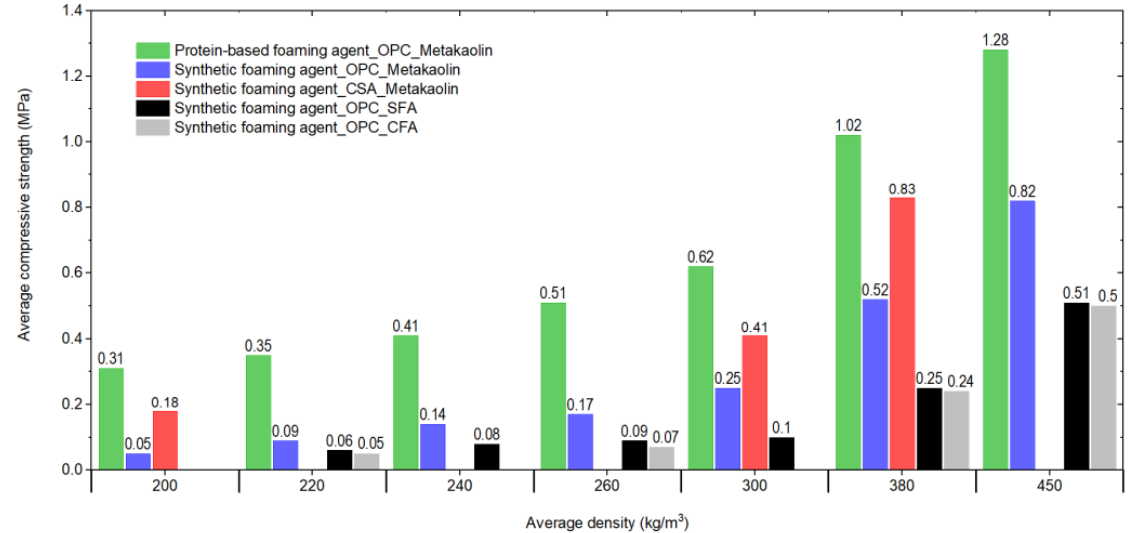
Figure 13. Average compressive strength for all tested foam concrete.